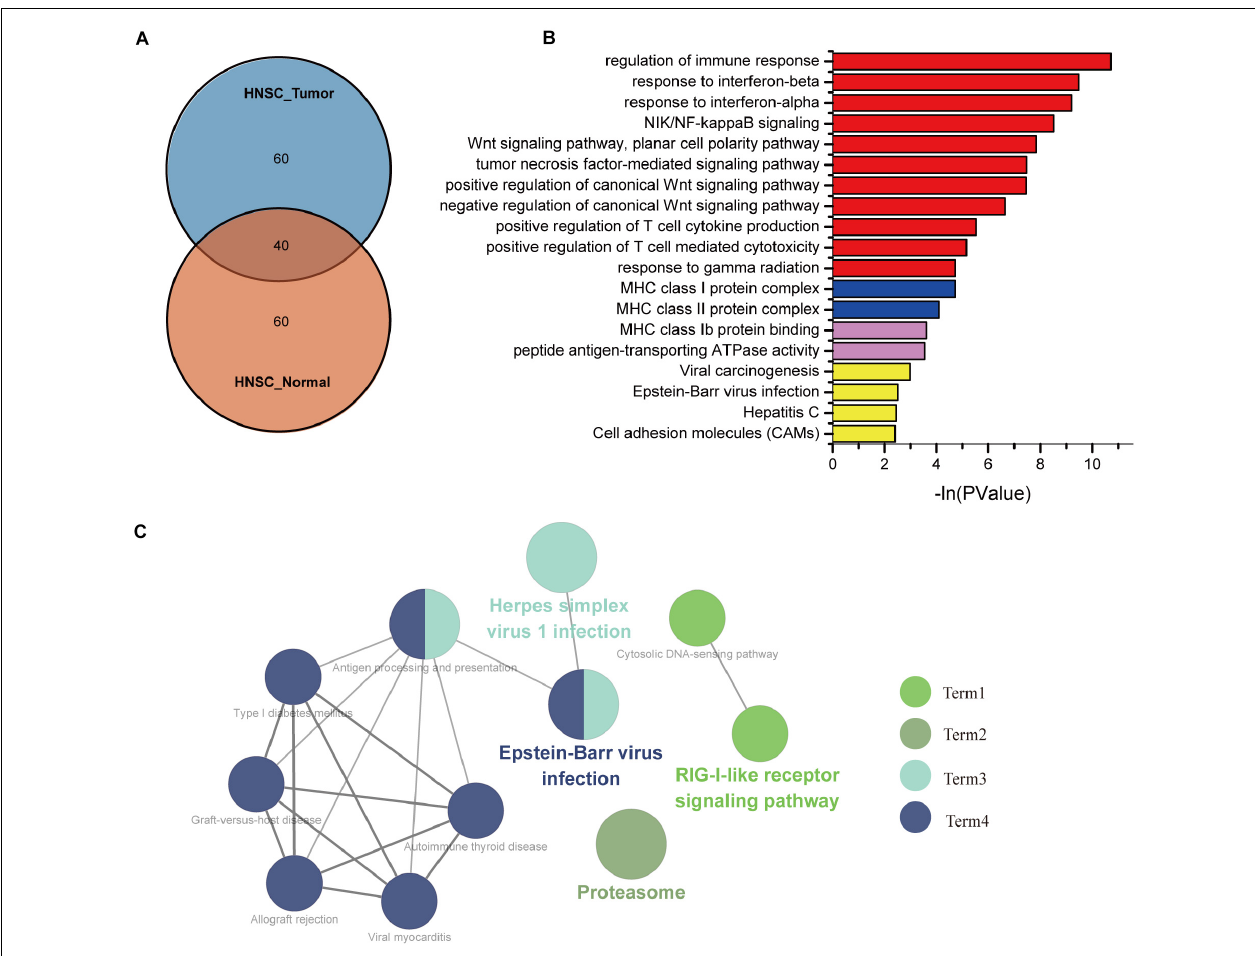
FIGURE 3 | The biological process associated with IFI44 in head and neck squamous cell carcinoma (HNSC). (A) The Venn of IFI44 co-expression genes in HNSC tumor samples compared with normal samples. (B) Gene Ontology (GO) analysis including biological processes (BPs), cellular components (CCs), and molecular functions (MFs) was conducted using DAVID database. (C) Kyoto Encyclopedia of Genes and Genomes (KEGG) pathway analysis in